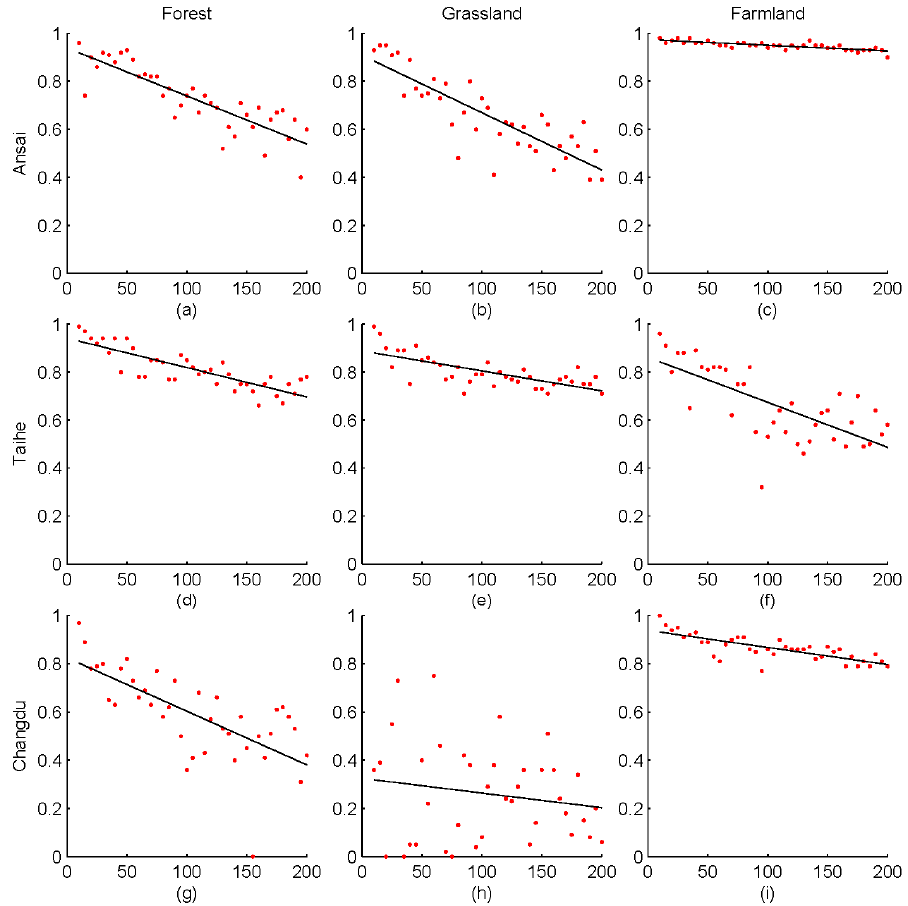
Figure 7. Relationship between the group number ( GN ) and fitting R 2 for Ansai’s forest ( a ), grassland ( b ), farmland ( c ), Taihe’s forest ( d ), grassland ( e ), farmland ( f ), and Changdu’s forest ( g ), grassland ( h ), farmland ( i ); the x -axis is GN , and the y -axis is R 2 .